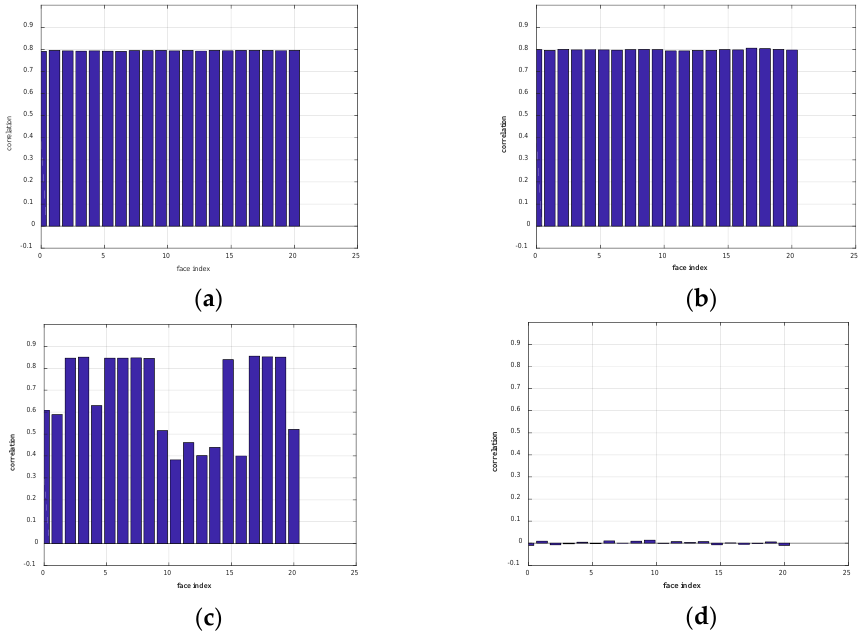
Figure 9. Correlation scores for authorised patterns (for ORL dataset) for ( a ) CFR1, ( b ) CFR2, ( c ) homomorphic transform followed by salting and ( d ) homomorphic transform followed by random kernel convolution.